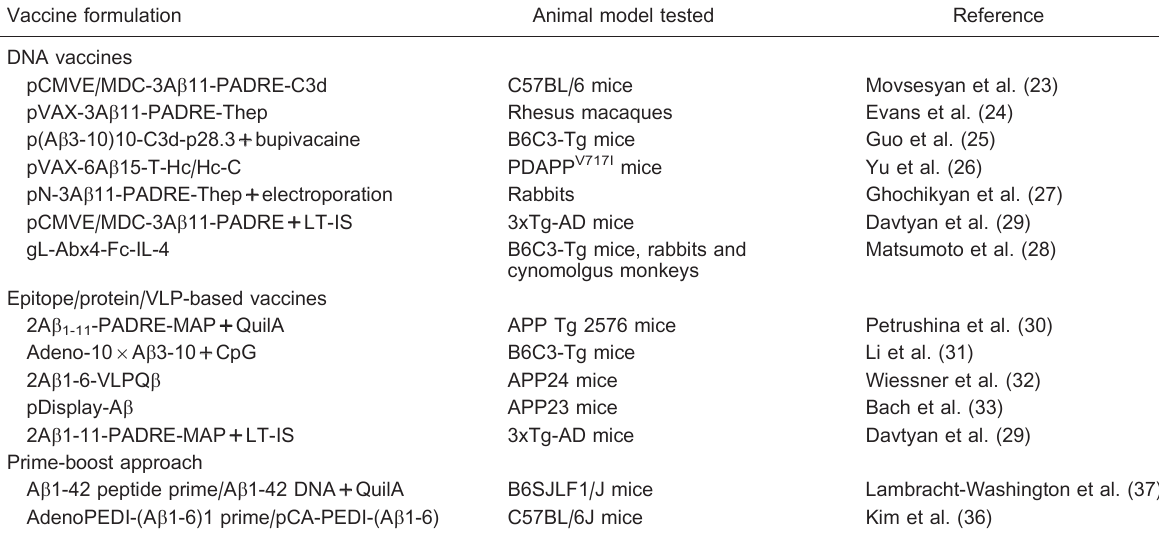
Table 1. Examples of vaccine formulations currently being tested against Alzheimer’s disease in animal